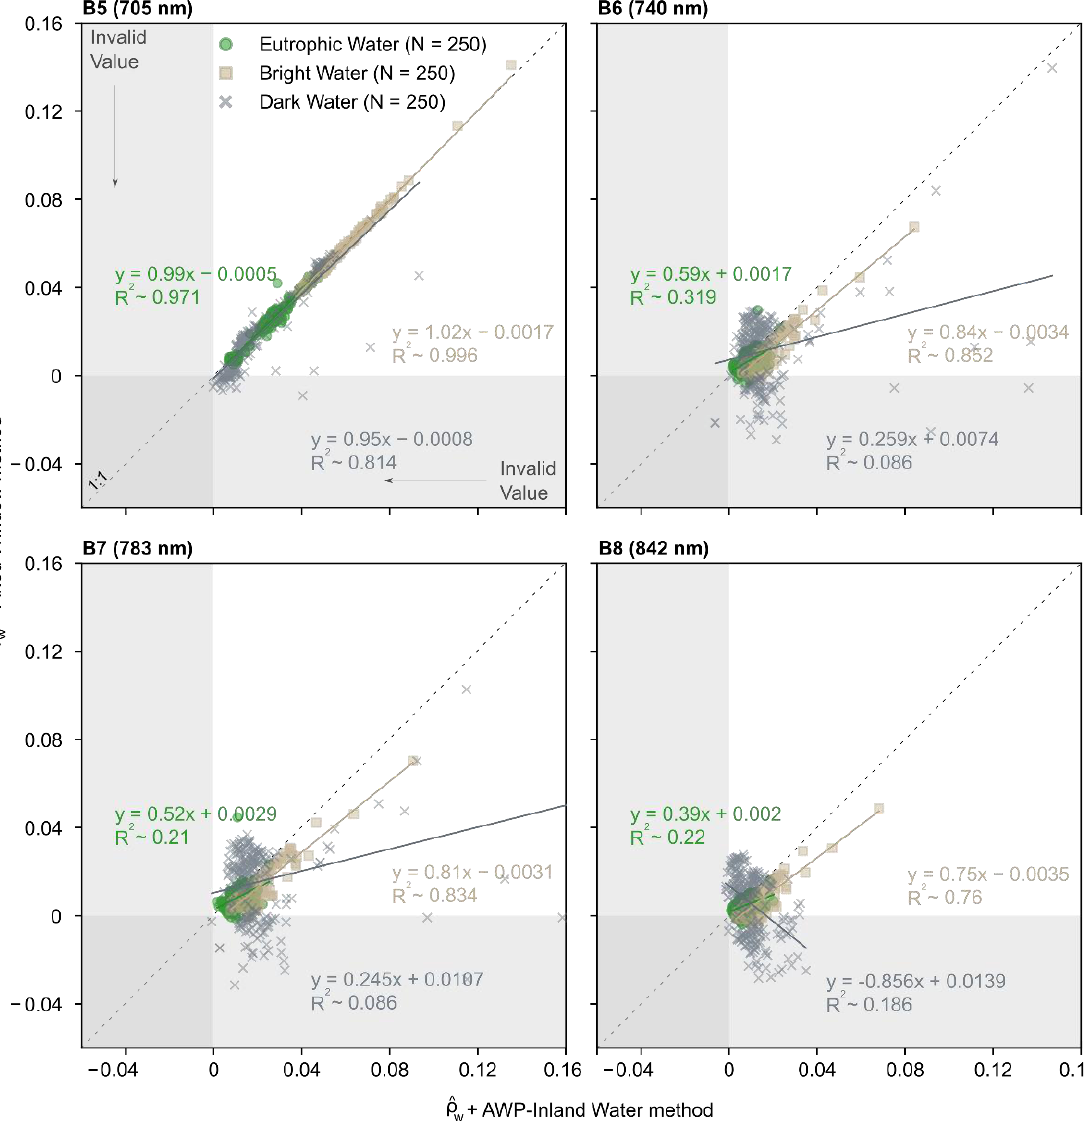
Figure 6. Water reflectance estimated from MSI considering the range of the adjacency effect generated from the fixed window versus AWP-Inland Water methods.